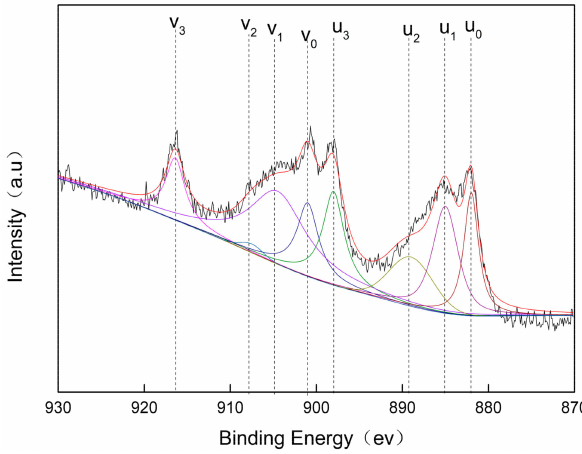
Figure 6. XPS spectrum of the Ce 3d orbital.